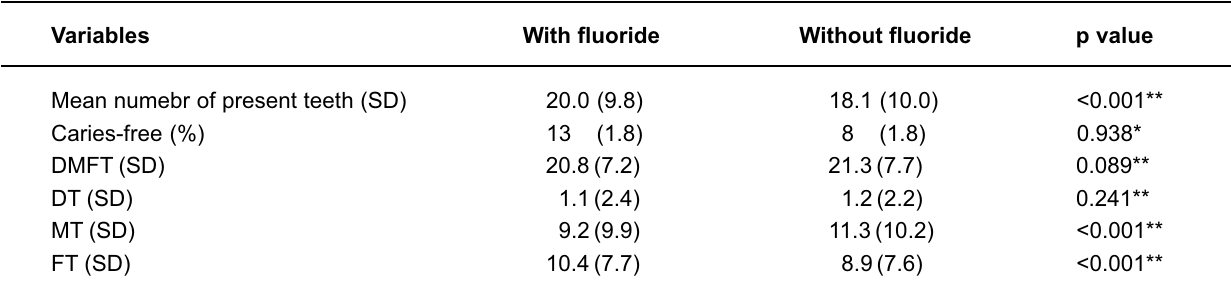
TABLE 5- Mean number of present teeth and caries experience according to fluoridated water status from public water supply. Southeastern state of São Paulo,